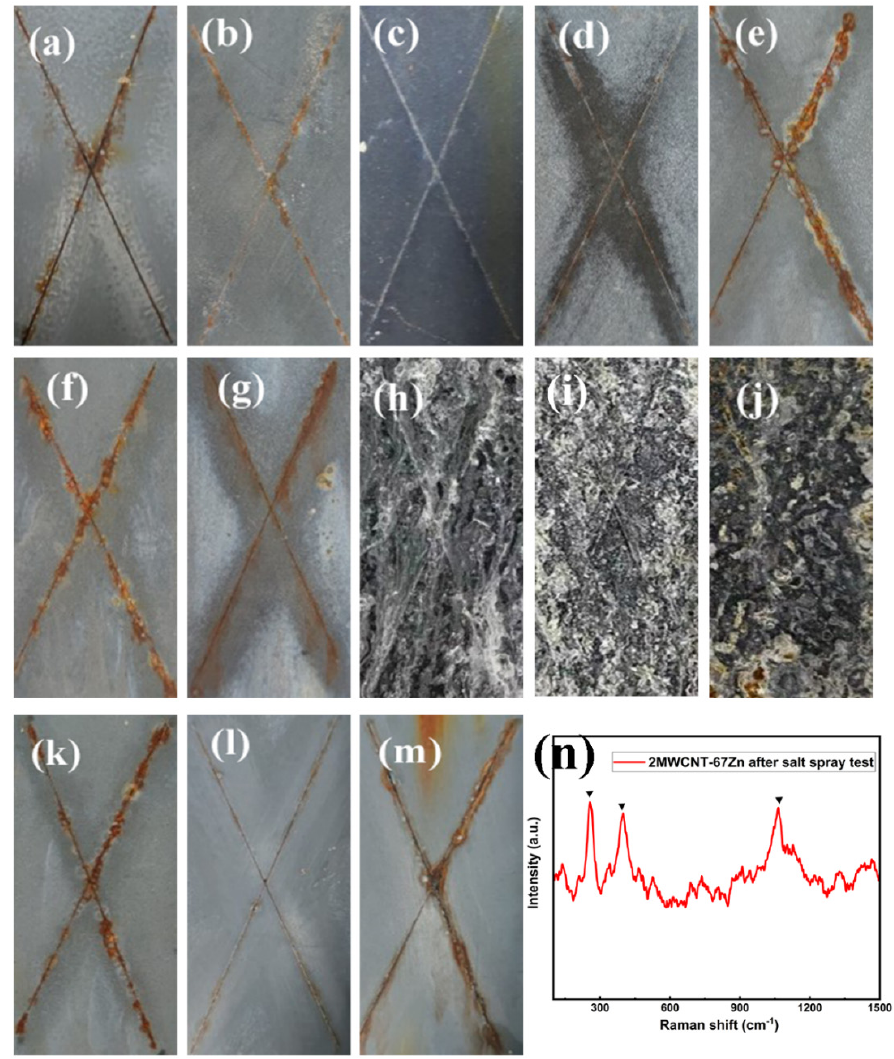
Figure 6. Salt spray test results: ( a ) 80Zn; ( b ) 1CB-80Zn; ( c ) 2CB-67Zn; ( d ) 4CB-67Zn; ( e ) 1CG-80Zn; ( f ) 2CG-67Zn; ( g ) 4CG-67Zn; ( h ) 1MWCNT-80Zn; ( i ) 2MWCNT-67Zn; ( j ) 4MWCNT-67Zn; ( k ) 1PANI-80Zn; ( l ) 2PANI-67Zn; ( m ) 4PANI-67Zn; ( n ) Raman spectrum of the zinc corrosion products of 2MWCNT-67Zn after salt spray test.